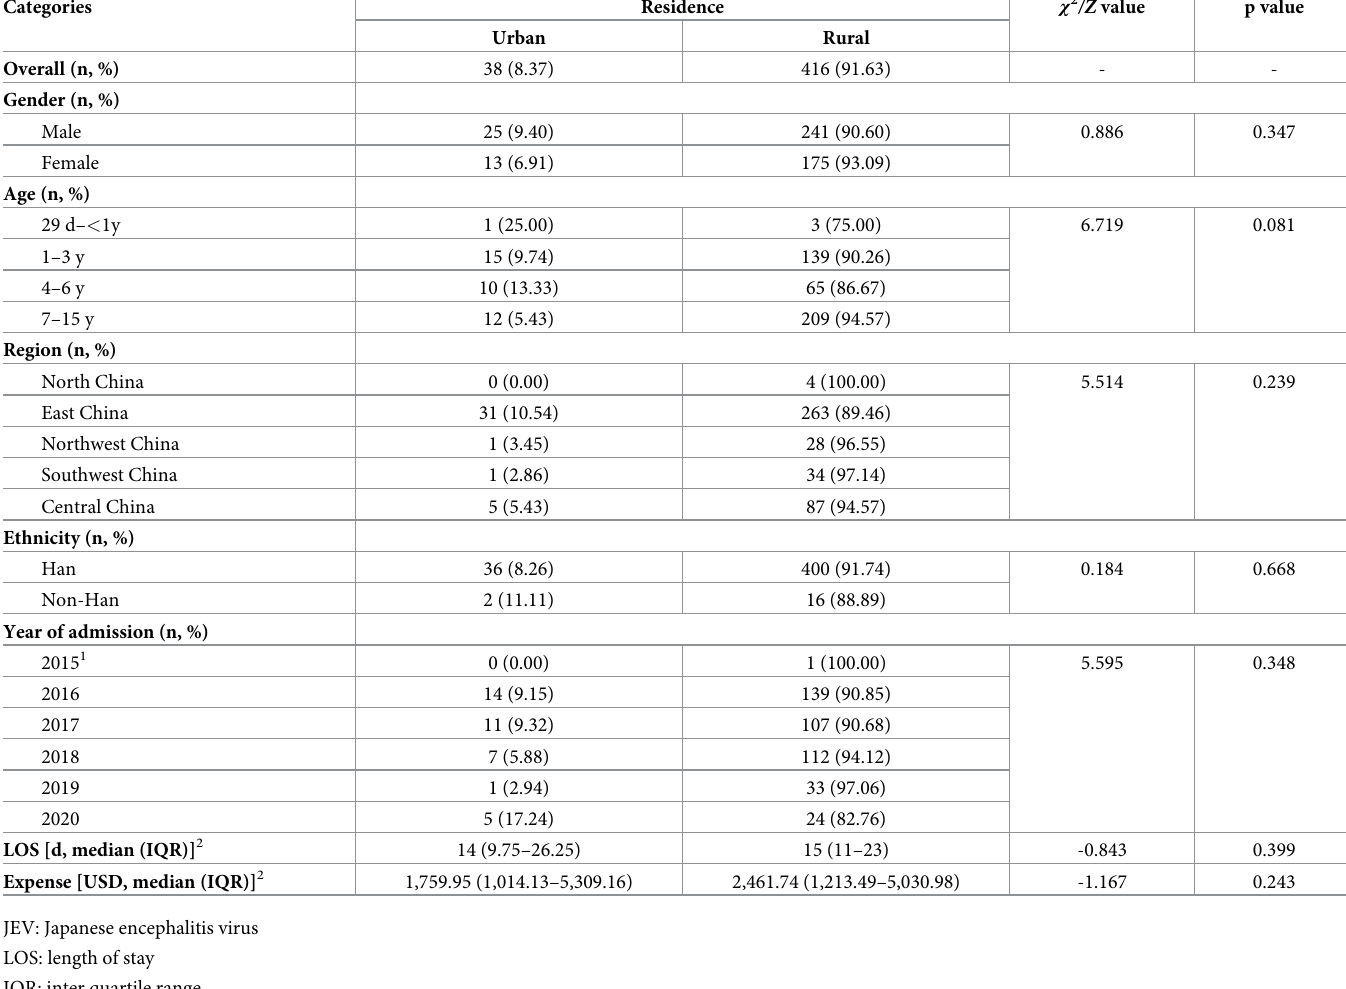
Table 4. The general sociodemographic characteristics and disease burden of JEV infection categorized by residence during pediatric hospitalizations from Decem- ber 2015 to December